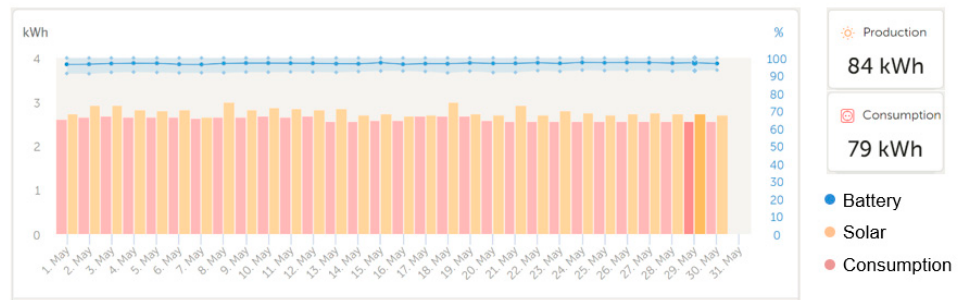
Figure 20. Energy analysis report of the LSF module during May 2021.